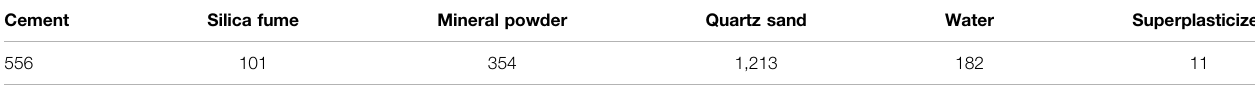
TABLE 1 | Mix proportion of ultra-high-performance concrete (UHPC) matrix.